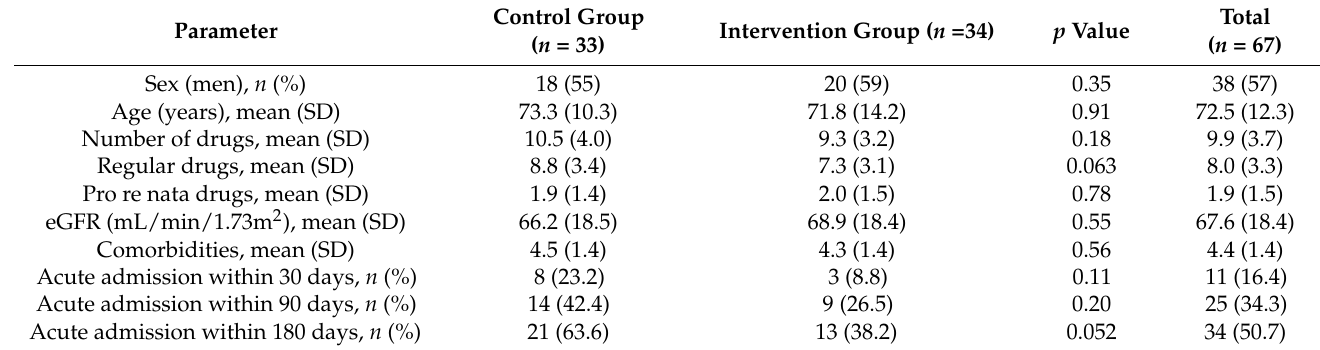
Table 1. Baseline characteristics of the included patients.